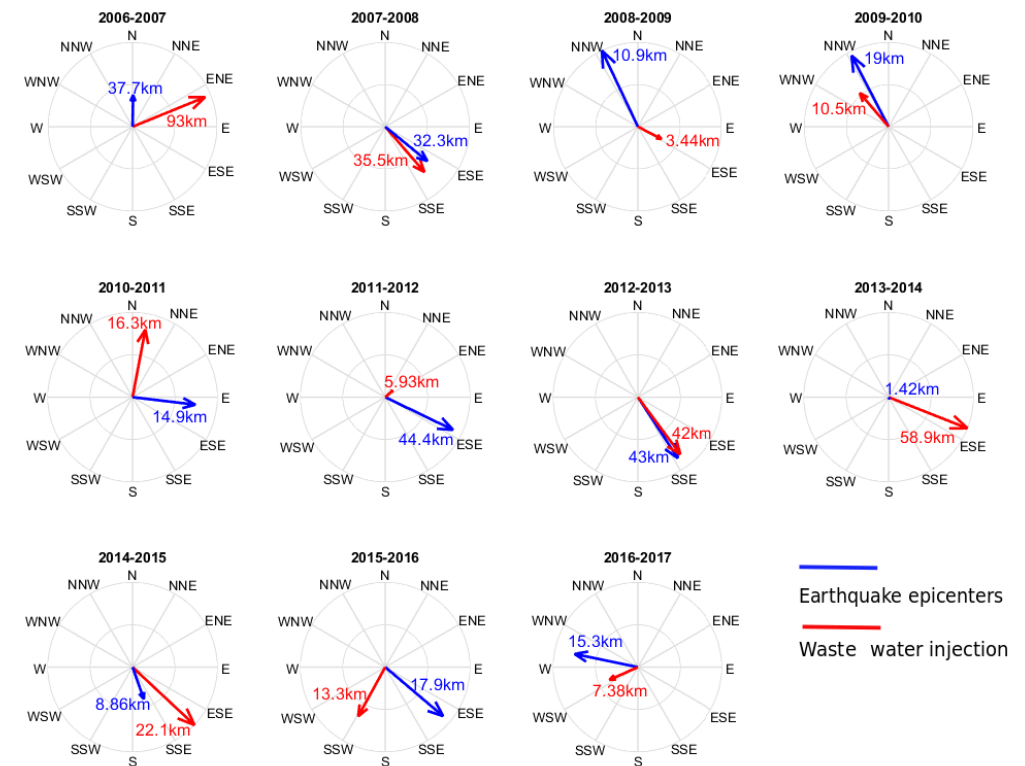
Figure 6. Yearly migration patterns between earthquakes weighted epicenters and wastewater injection activity in Oklahoma since 2006. Red and blue lines mean the average displacement of mean weighted centers of wastewater injection and earthquakes between consecutive years. The average displacement distance is also indicated within each compass diagram.